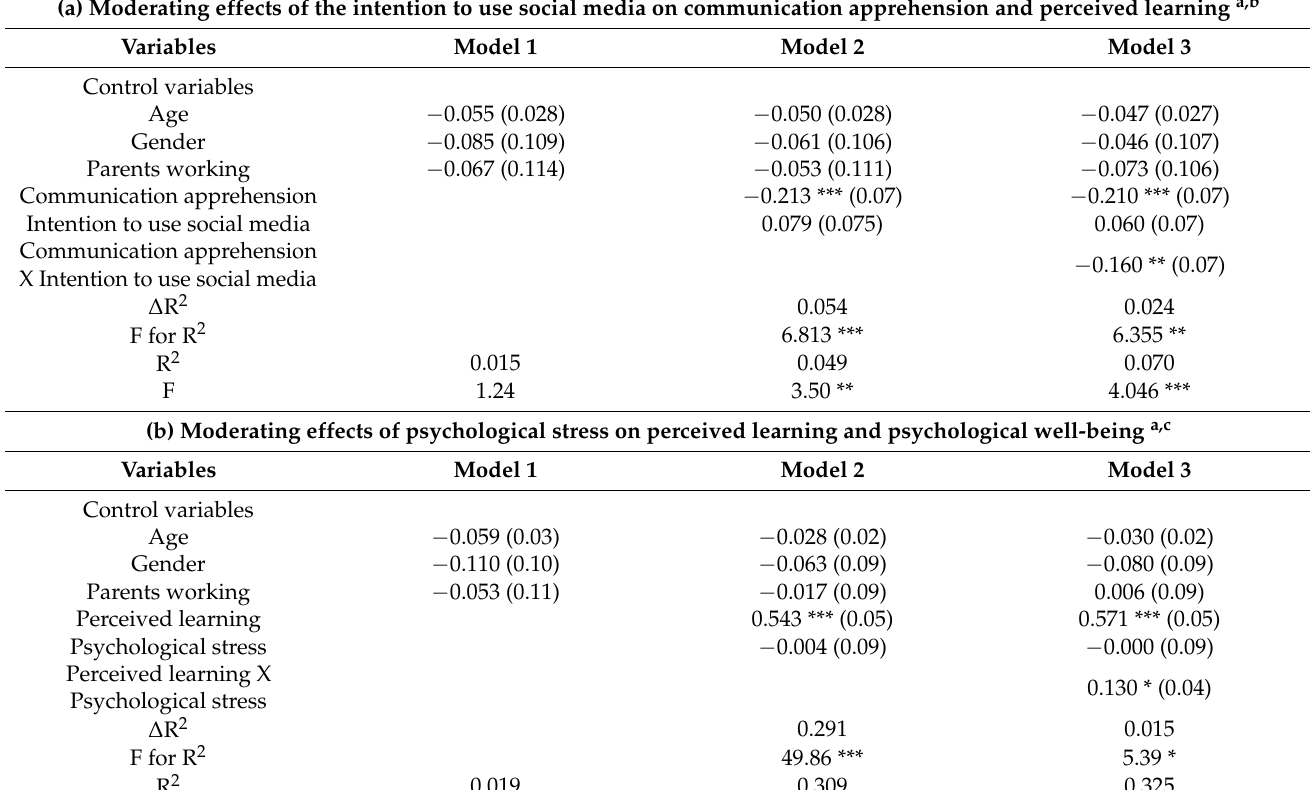
Figure 2. SEM model with the results of the moderation analysis. Table 3. Results of the hierarchical regression